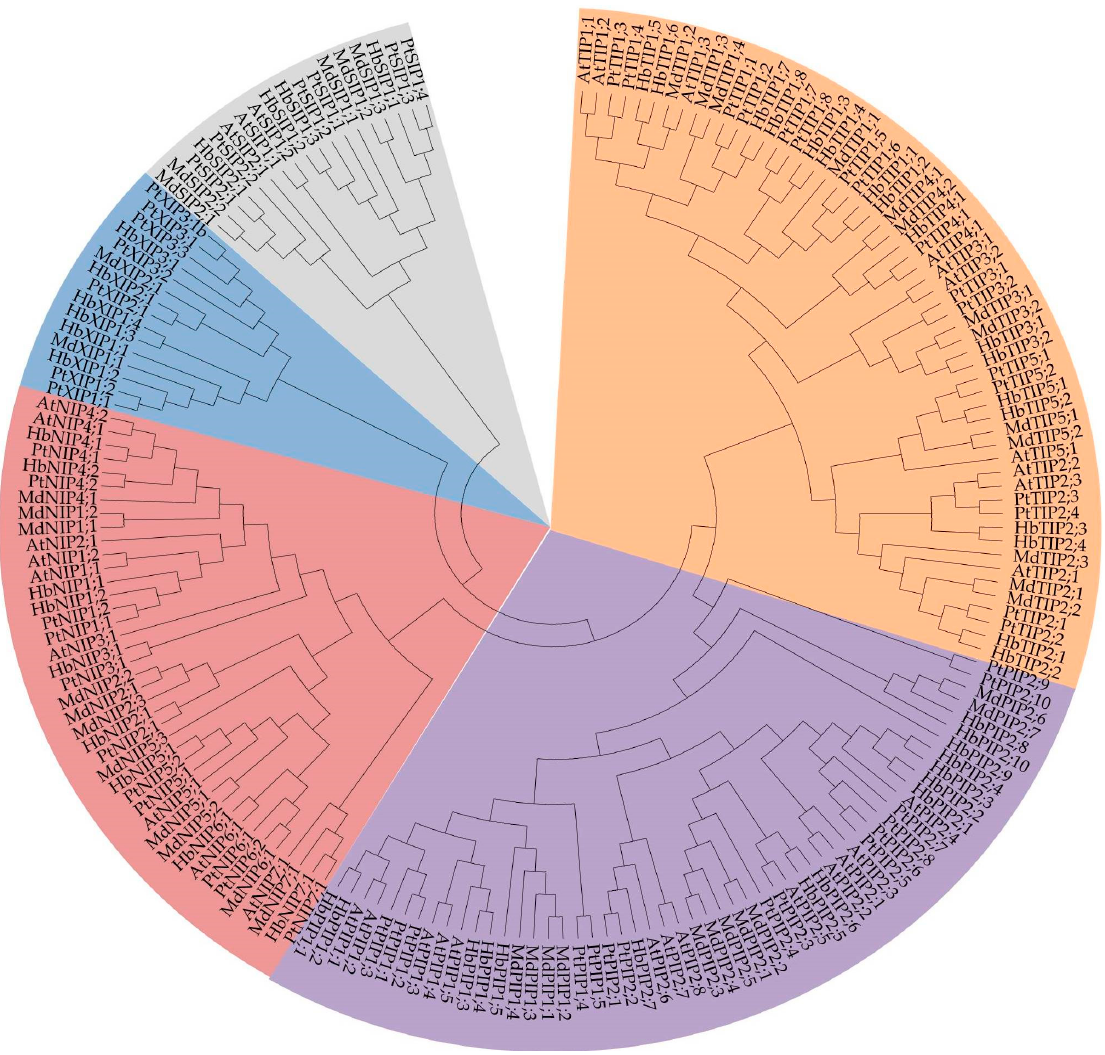
Figure 1. Phylogenetic tree of AQPs from Arabidopsis thaliana , Populus trichocarpa , Hevea brasiliensis, and Malus domestica . The protein sequences were aligned by ClustalX and the phylogenetic tree was constructed by the Neighbor-Joining method (1000 bootstrap replicates) in the MEGA6 software. The subgroups are marked by a colorful background (orange for TIPs, purple for PIPs, red for NIPs, blue for XIPs and gray for SIPs).